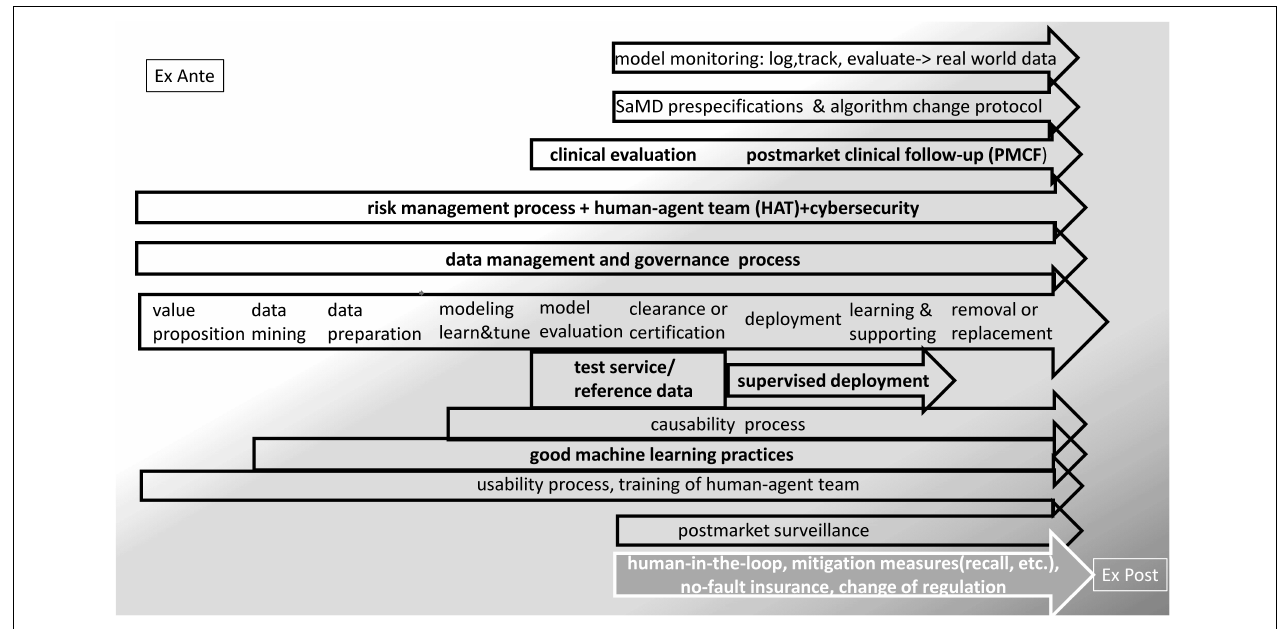
FIGURE 2 | Embedding the MLMD life-cycle in regulation—existing approaches and